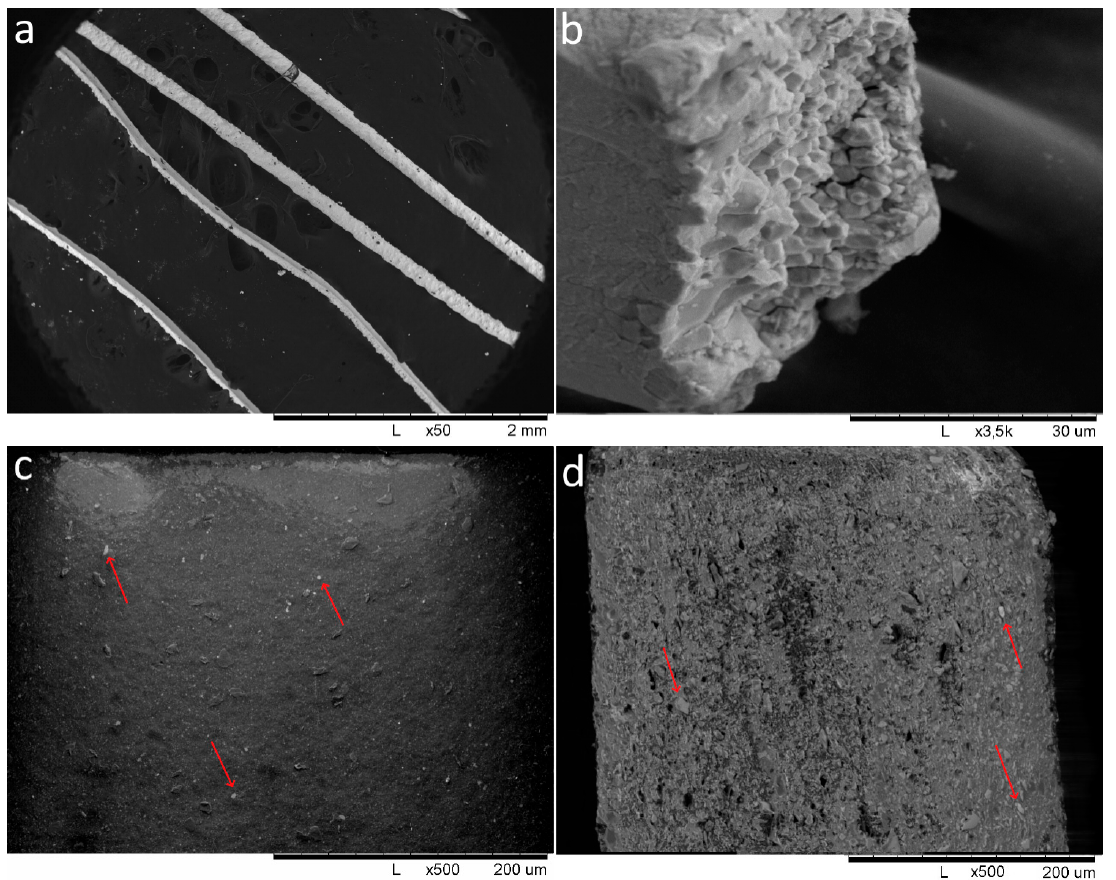
Figure 1. SEM images of obtained fiber of the Ti 20 Zr 20 V 20 Nb 20 Hf 20 alloy ( a ), structure of the fiber surface ( b ), surface of the composite C-12 ( c ), cross-sections of the composite C-12 ( d ), The arrows indicate the inclusions of